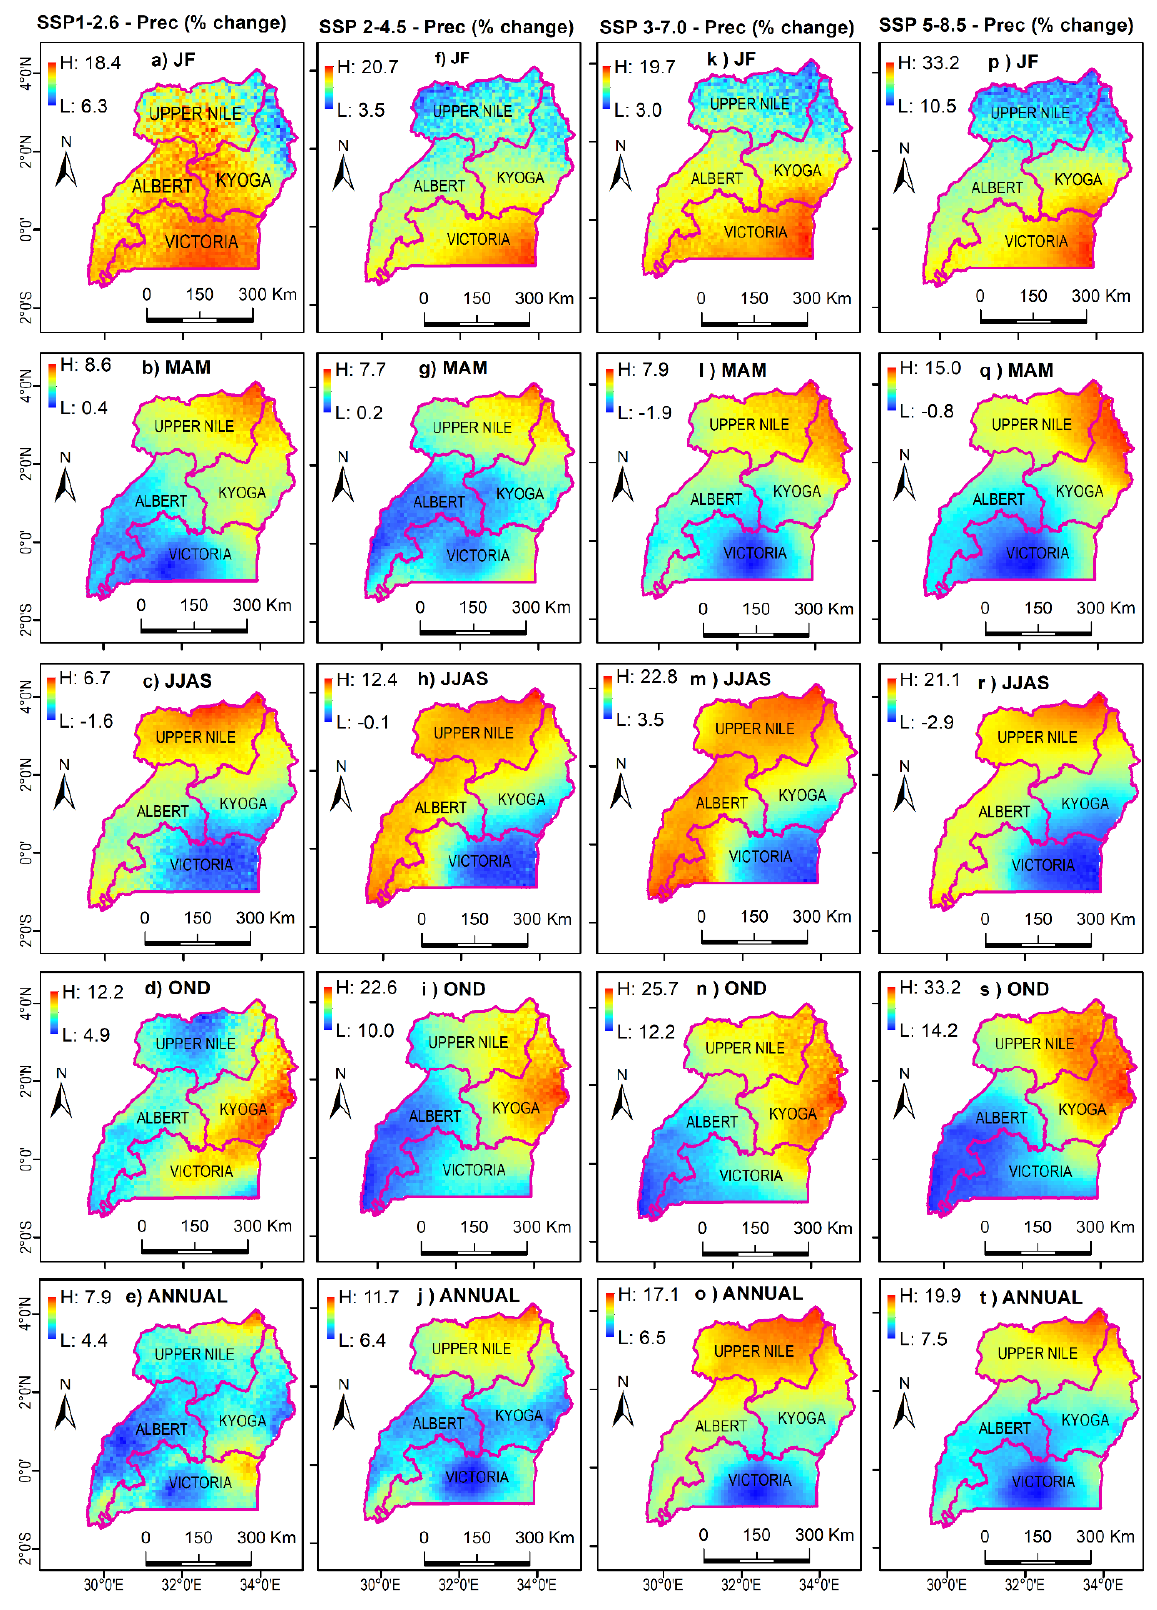
Figure A2. Percentage change in precipitation over the period 2061 – 2080.